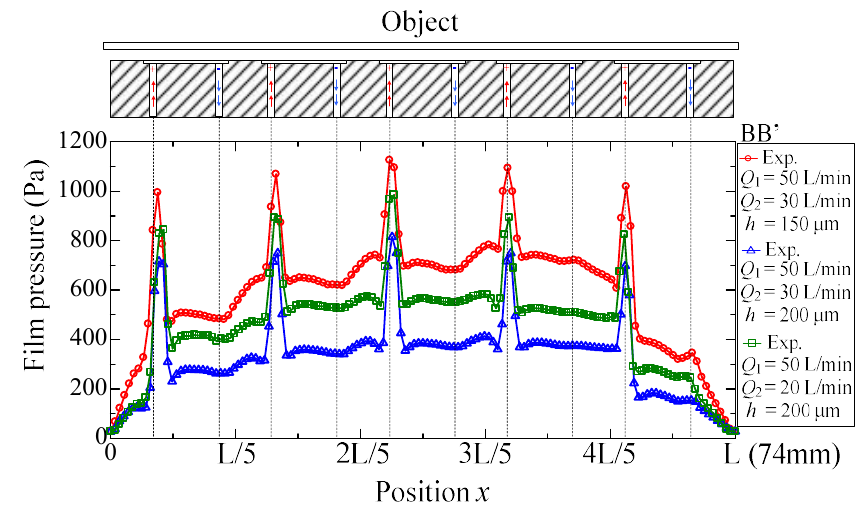
Figure 5. Film pressure distribution.